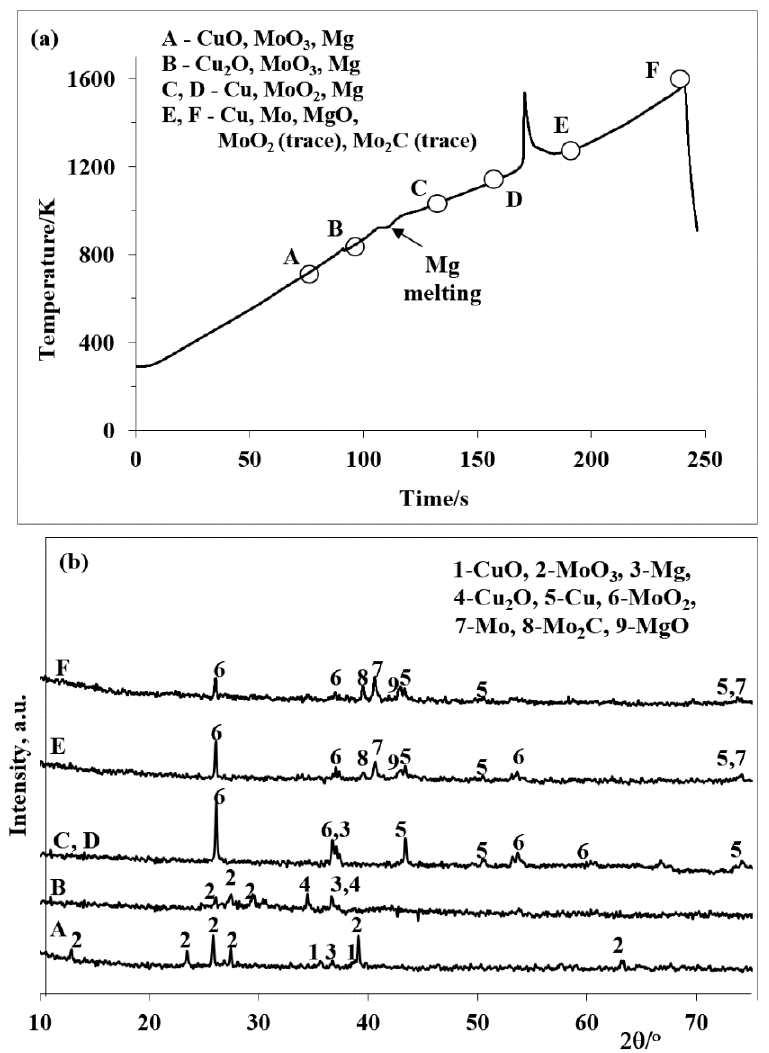
Figure 11. Heating thermogram of the CuO + MoO 3 + 1.2Mg + 2.15C mixture ( a ) and XRD analysis results ( b ) of the quenched samples at different characteristic temperatures, A—T = 773, B—873, C—1023, D—1163, E—1263, F—1573 K, V h = 300 K min − 1 . The microstructural analysis of the quaternary CuO + MoO 3 + 1.2Mg + 2.15C mixture (Figure S1), and of the quenched samples at different characteristic temperatures, T = 873 K (Figure 12), T = 1023 K, 1163 K (Figure S9), T = 1263 K, T = 1573 K (Figures 13, 14 and S10) are presented below to demonstrate the microstructure evolution during the high heating conditions. Initial CuO + MoO 3 + 1.2Mg + 2.15C mixture contains monoclinic CuO (outlined orange), orthorhombic MoO 3 (outlined blue), carbon (outlined yellow), magne- sium (outlined green). During the heating up to 873 K (before Mg melting) coarse Mg particles are still sep- arately present (Figure 12a, green outlined platelets) and didn’t participate in the interac- tion yet (Figure 12b,c). Another three components appear together in prealloyed state in the form of two different microstructural entities—ribbed laminates (spectrum 433 and points marked 1) and nanospherical agglomerates (spectrum 434 and points marked 2) (Figure 12d). More specifically, according to EDS spectrum (Figure 12e), the alloyed re- gions (Figure 12c,d spectrum 433) comprise more Mo and O (according to XRD analysis results it should correspond to MoO 3 , according to EDS analysis atomic ratio is Mo:O = 1:3.5), and agglomerated particulates (spectrum 434, Figure 12c,d) have more copper and carbon content, and some oxygen is also present (in all probability there are carbon and